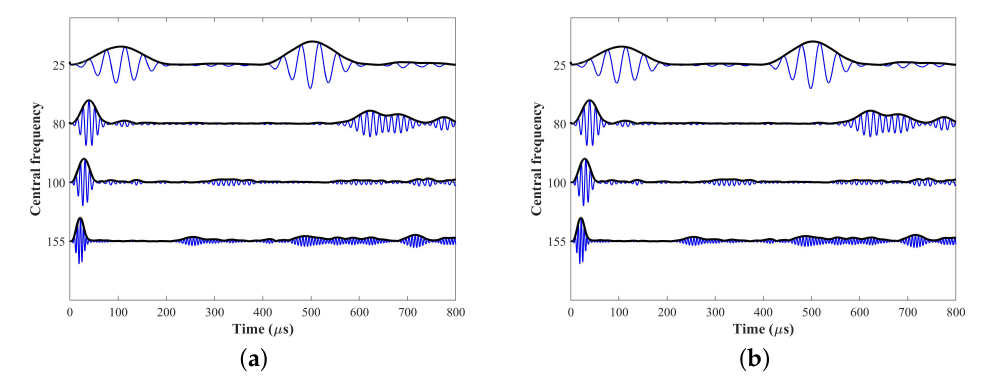
Figure 14. Time-domain signals from damaged FE model at all four frequencies: ( a ) #1, ( b ) #2.